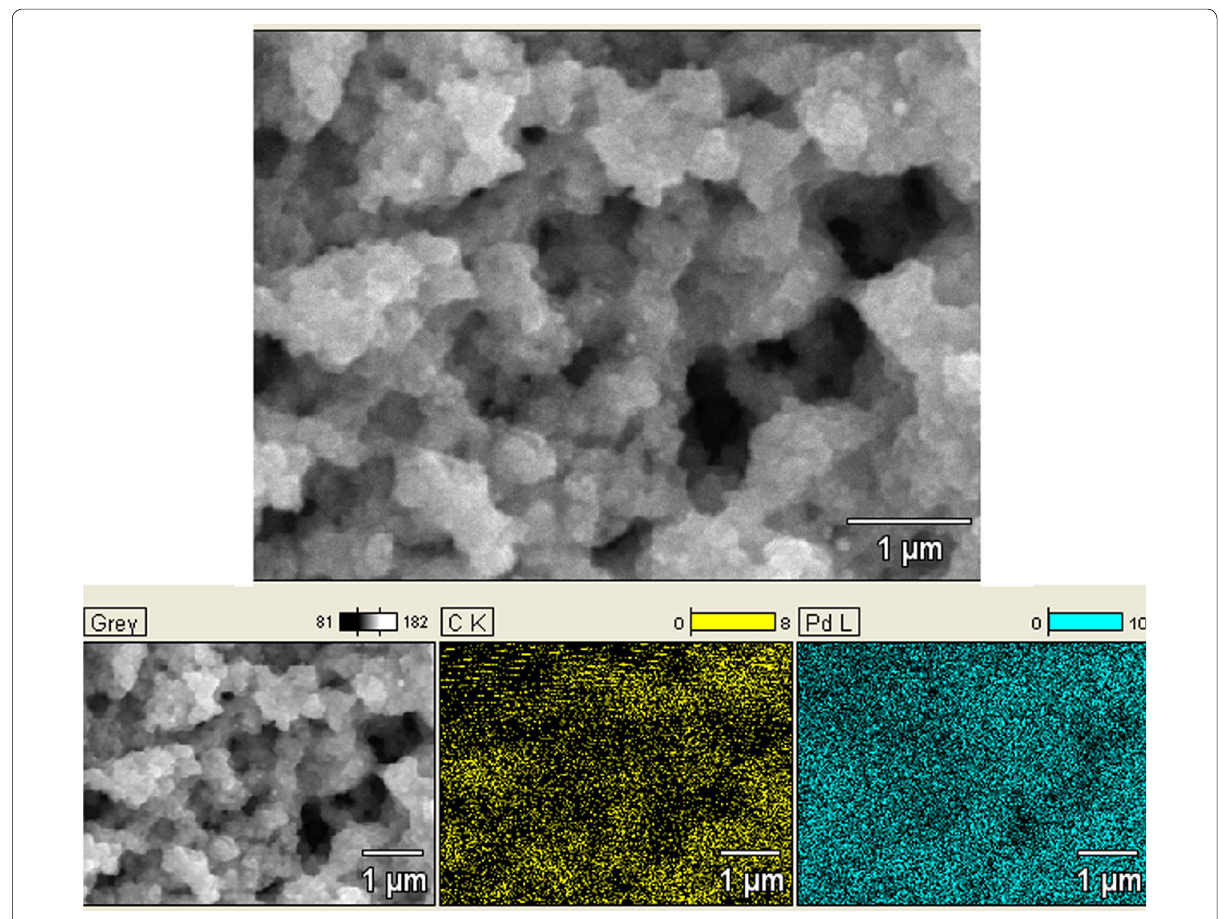
Fig. 9 SEM image and EDX analysis of Pd nanoparticles incorporated PAni film